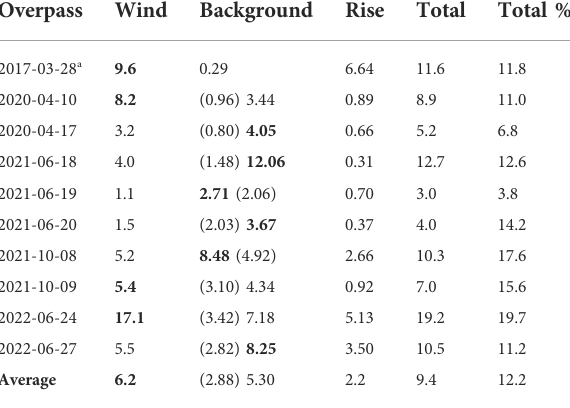
TABLE 3 Component Uncertainties in ktCO 2 /day. For OCO-3 two different background ensembles were calculated: 1) variable radius and 2) full circle, east, west with the lower uncertainty in parentheses as the higher value was used in the total uncertainty. The largest contributor to the total uncertainty is shown in